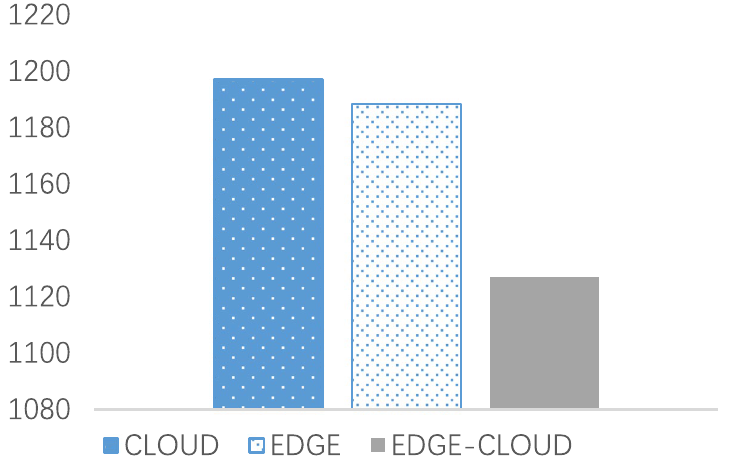
Fig. 12 Application latencies using edge, cloud, and